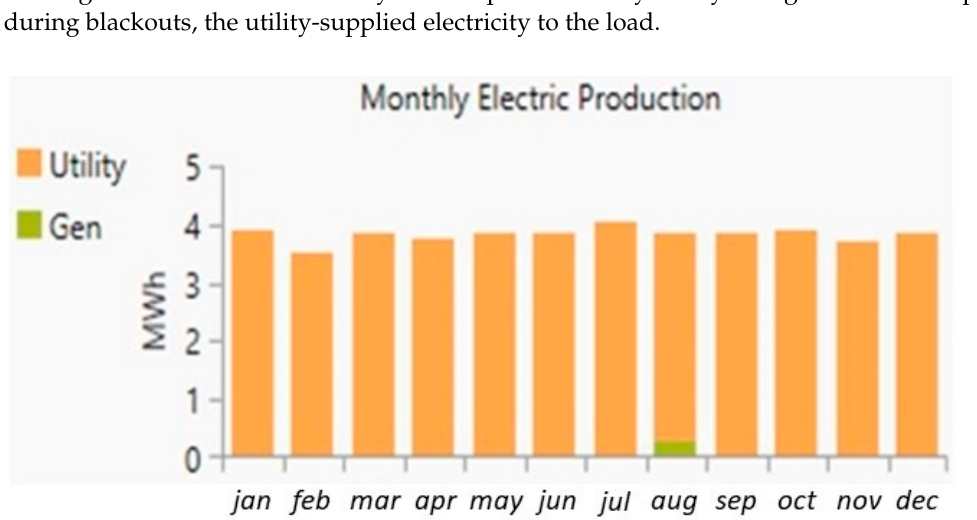
Figure 13. Generator output power.